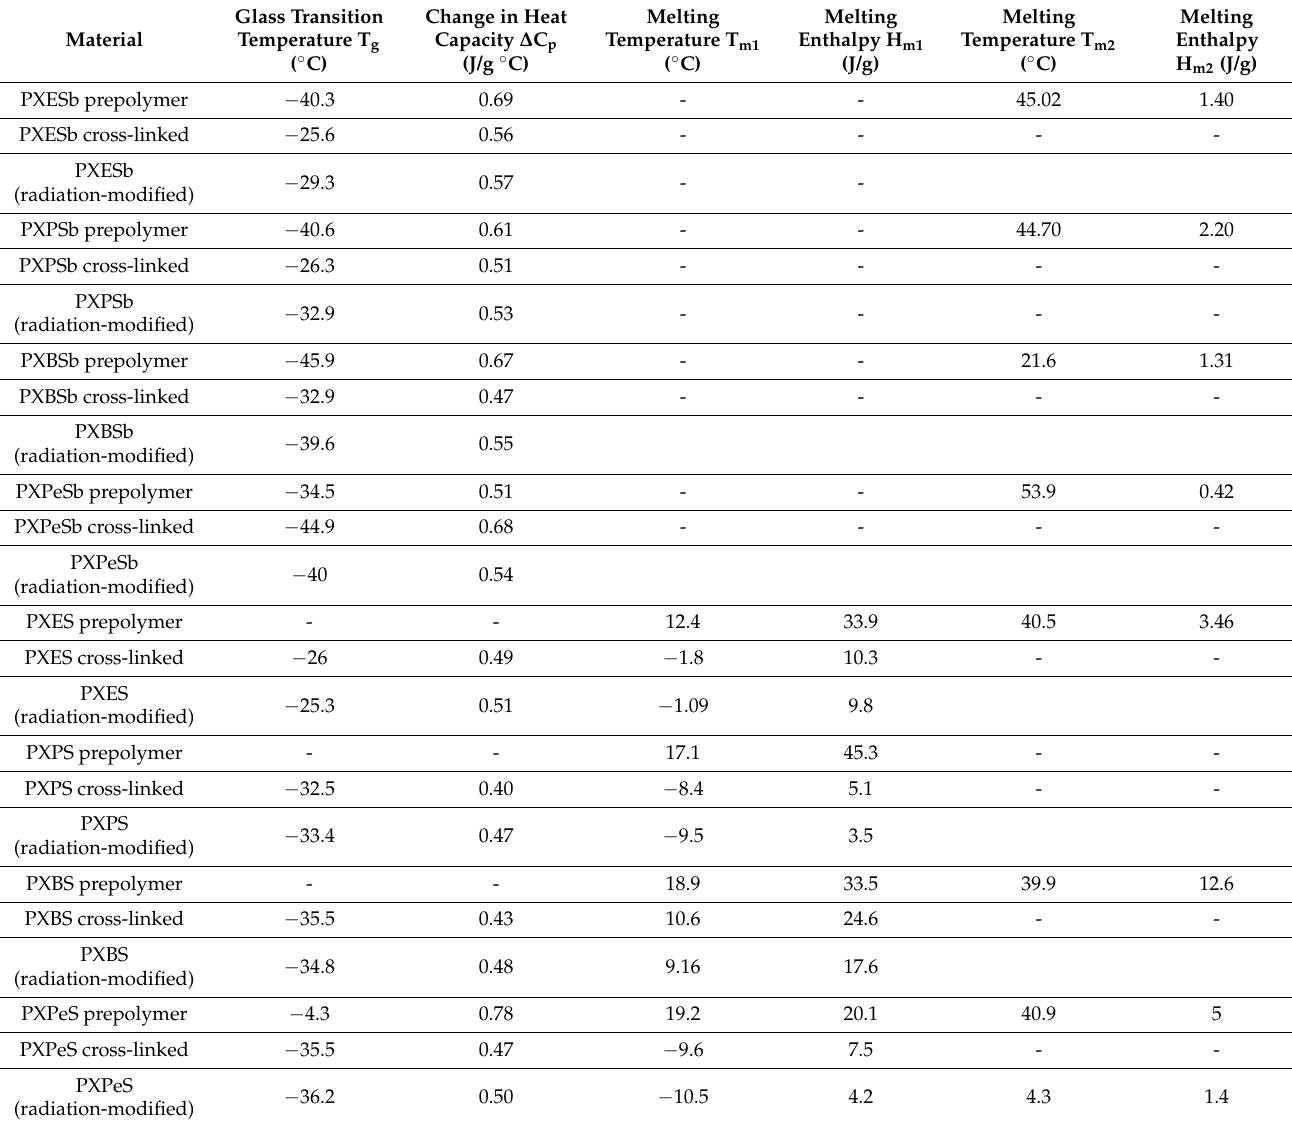
Table 2. DSC thermal data of poly(xylitol dicarboxylate-co-diol dicarboxylate) before and after